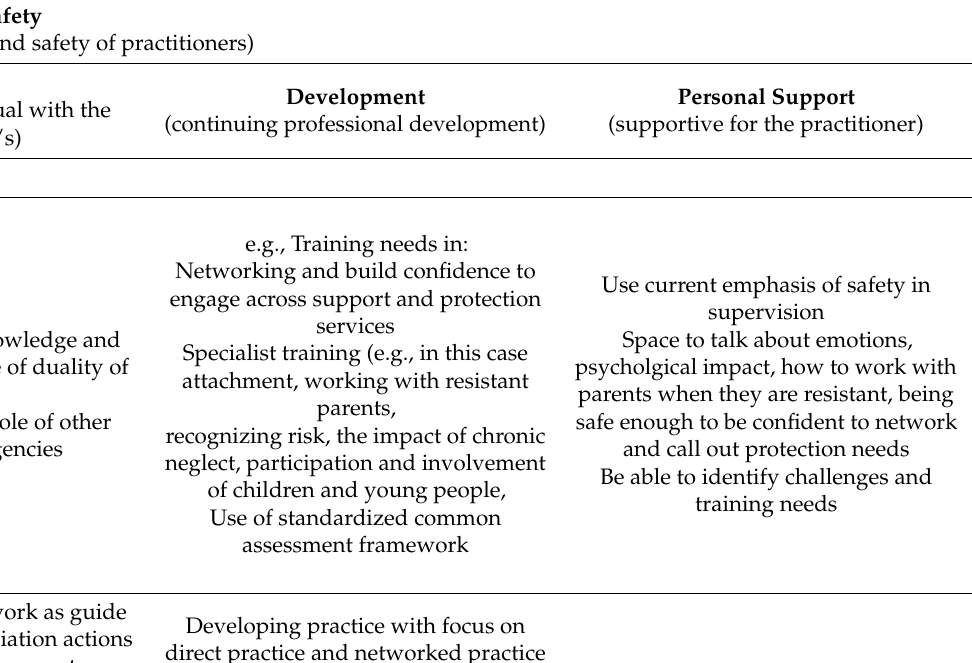
Table A1. Illustrative Example of Case Study as Applied to Child Protection and Welfare Social